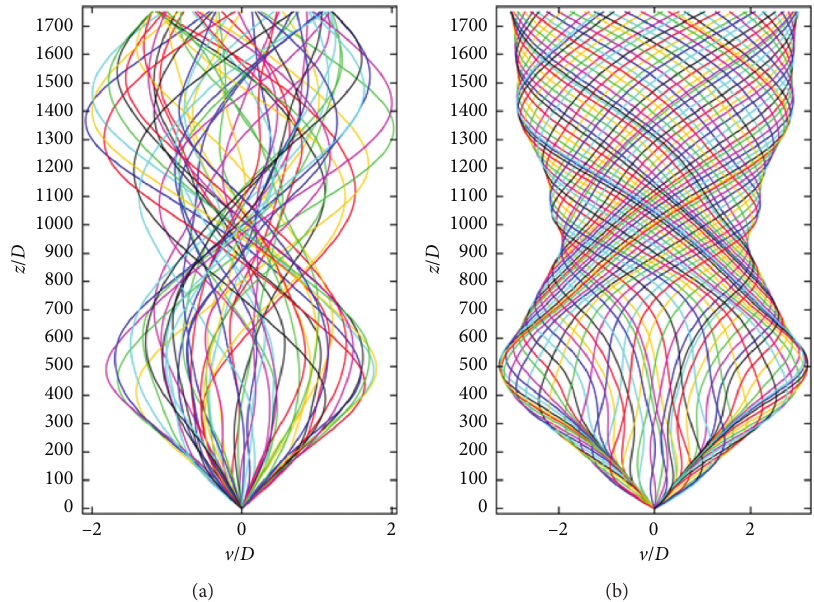
Figure 10: The influences of axial tension excitation amplitude on the displacement response of cross-flow for an (a) excitation amplitude A / D � 1.2 and (b) excitation amplitude A / D �